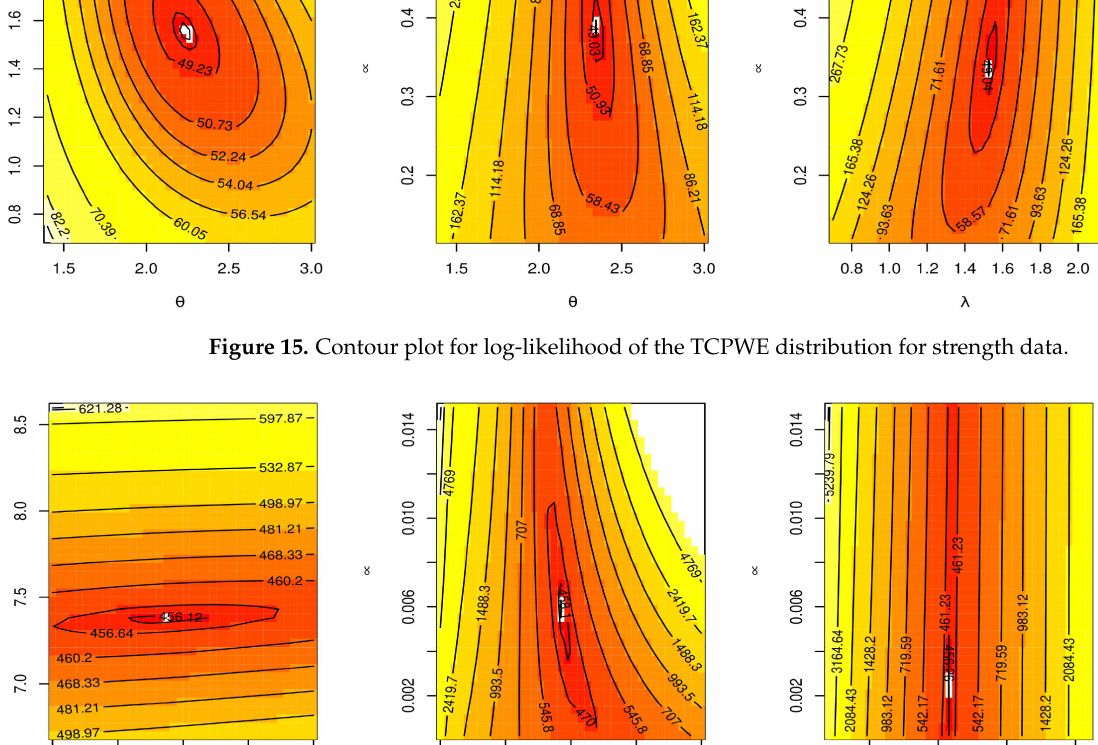
Figure 16. Contour plot for log-likelihood of the TCPWE distribution for fatigue times